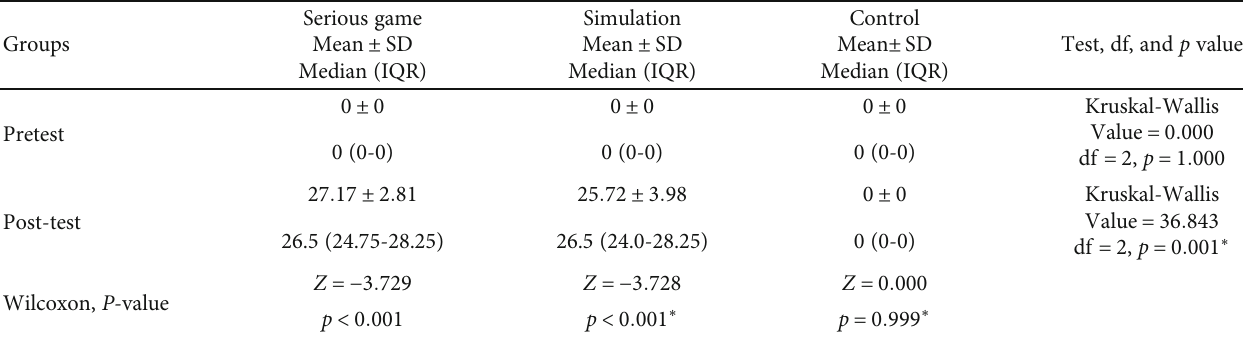
Table 3: Comparison of CPR skill acquisition across three study groups (simulation, serious game, and control).